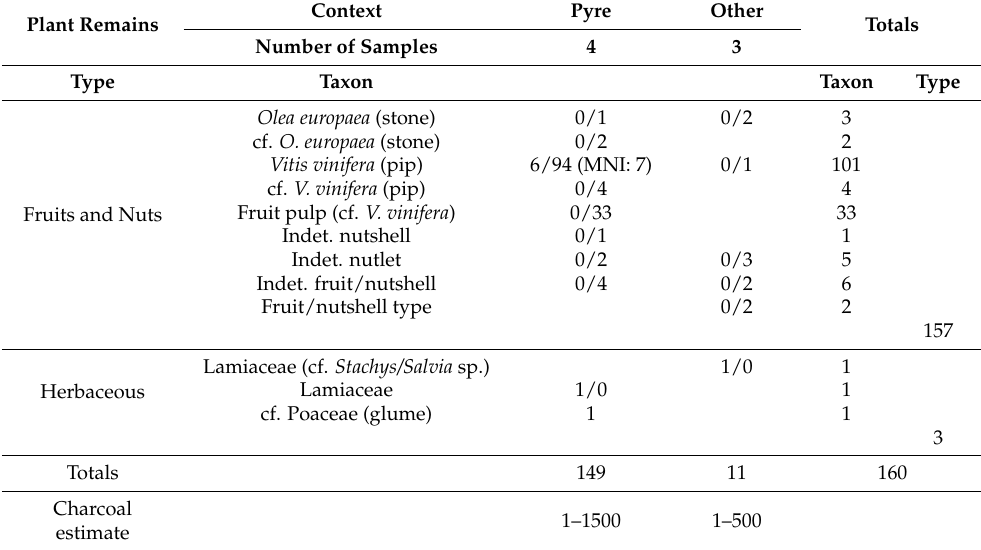
Table 2. Archaeobotanical data for Kophinas